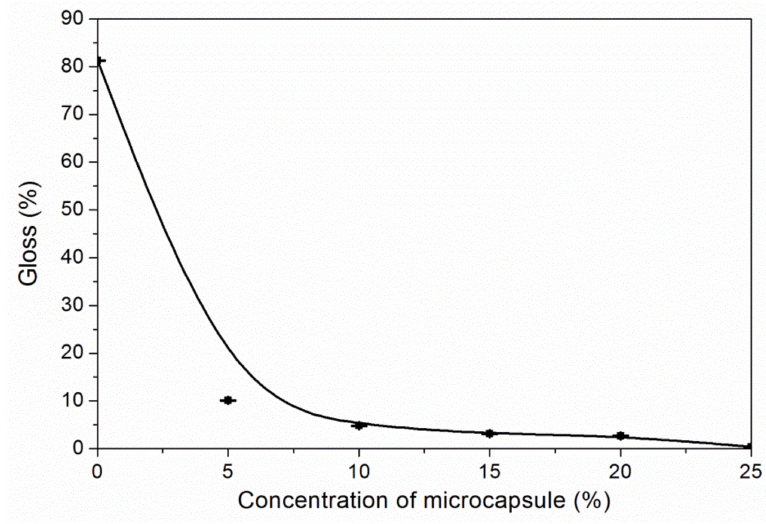
Figure 5. E ff ect of di ff erent concentration of microcapsules on the gloss of waterborne